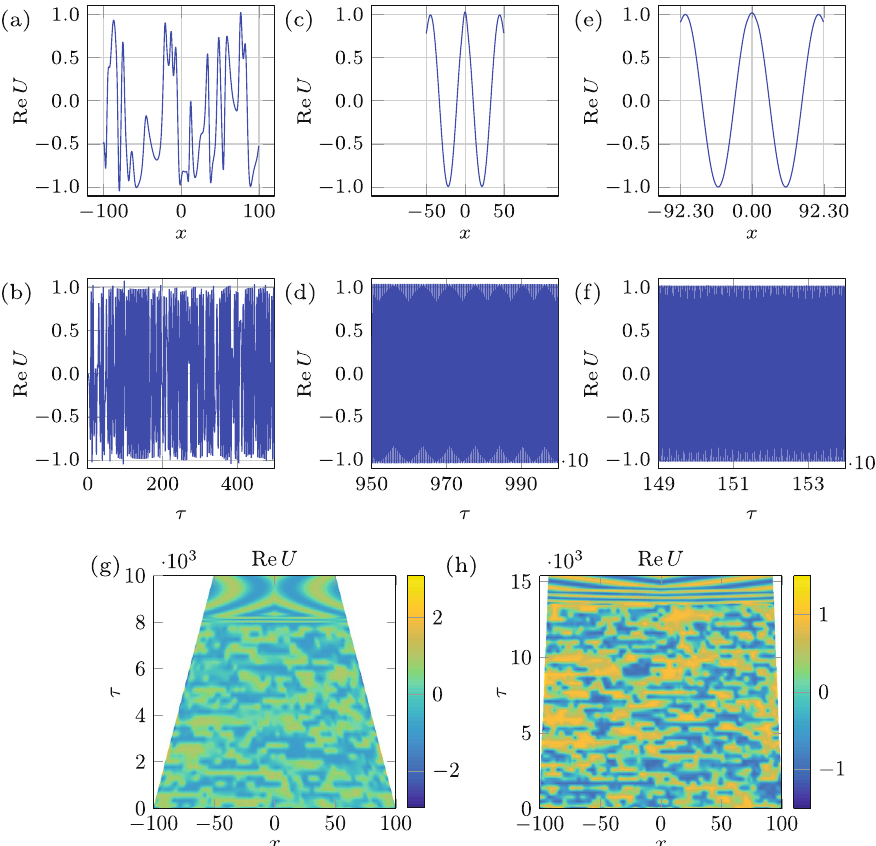
Figure 8. Domain evolution rate effect. ( a , b ) depict the spatio-temporal bichaos used as the initial state with domain size L = 200 and (α , β) = ( 0.8, − 1.4 ) . The domain shrinkage (cid:31) L = 100.00 and (cid:31) L = 15.40 , over which the regime changes from chaotic to periodic, with two different rates v = 10 − 2 and 10 − 3 corresponding to the middle ( c , d ) and right columns ( e , f ), respectively. ( g , h ) Space-time plots of the of the two processes indicating the transition over δ L = 22.91 and δ L = 2.29 ,